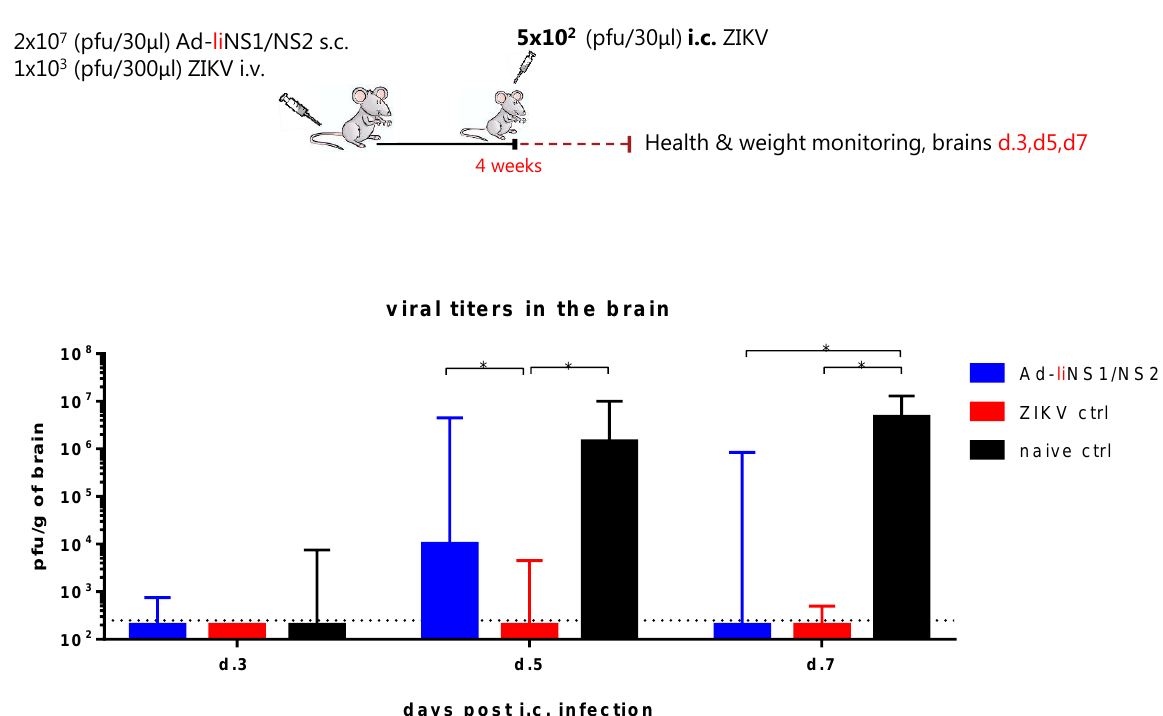
Figure 4. Kinetics of viral clearance in Ad-liNS1/NS2 vaccinated mice. WT C57BL/6 mice were vaccinated s.c. with 2 × 10 7 pfu of either Ad-liNS1/NS2 and four weeks later, these mice, along with ZIKV-immune and naive mice, were challenged i.c. with 5 × 10 2 pfu ZIKV. On days 3, 5, and 7 post i.c. challenge, brains were removed and viral titers were determined by a standard plaque assay. The detection limit for virus in brain was 250 pfu/g organ and is displayed as a stippled line. The results represent the group medians with range and are pooled from two independent experiments. * p <